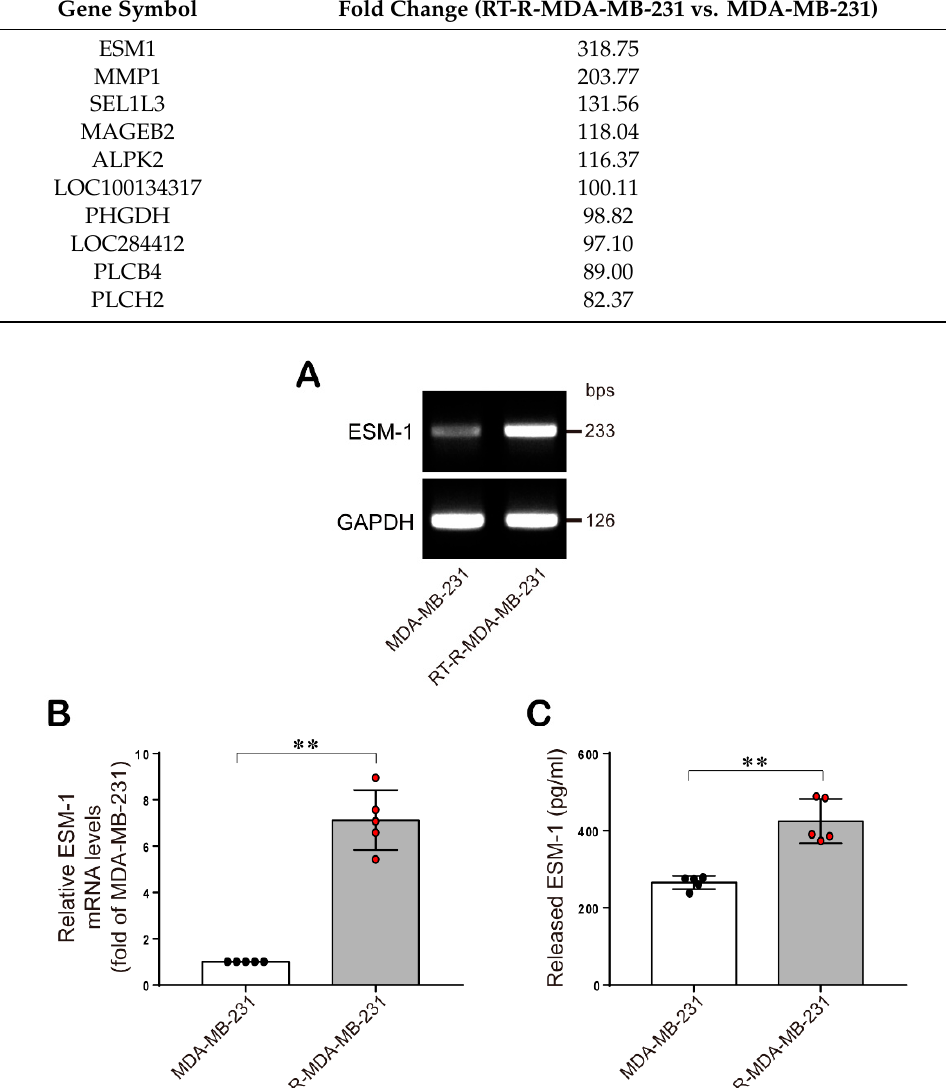
Table 1. Top 10 upregulated genes in RT-R-MDA-MB-231 compared to MDA-MB-231.